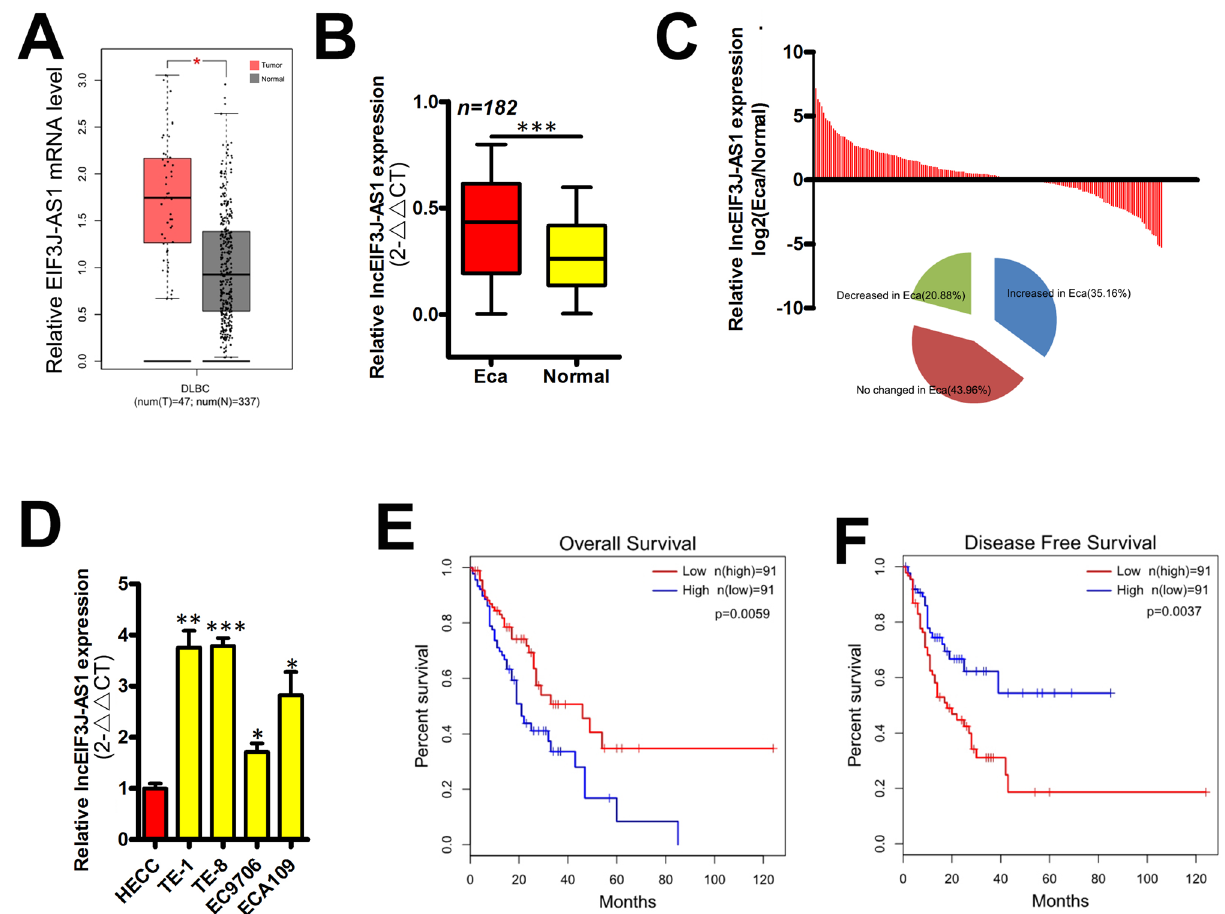
Figure 1. EIF3J-AS1 levels are increased in ECa. ( A ) Expression of EIF3J-AS1 in ECa and paired normal tissue samples from the GEPIA data. ( B ) Expression of EIF3J-AS1 was measured in ECa and paired normal tissue samples via qRT-PCR. ( C ) Histogram and pie chart of the proportions of Eca samples in which EIF3J-AS1 expression was up-regulated (64/182, 35.16%, blue), down-regulated (38/182, 20.88%, green), or no change (80/182, 43.96%, red). Log2 (T/N) expression value > 1 as higher expression, which < − 1 as lower expression, and between − 1 and 1 as no significant change. ( D ) Expression of EIF3J-AS1 was measured in ECa and control cell lines. ( E , F ) Overall survival (OS) and Disease-free survival (DFS) in ECa patients. Kaplan Meier (KM) curves were plotted for survival analysis. p-value *< 0.05; **< 0.01; ***<